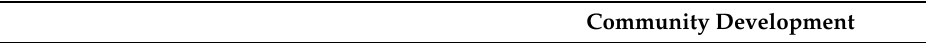
Table 7. Effect size f 2